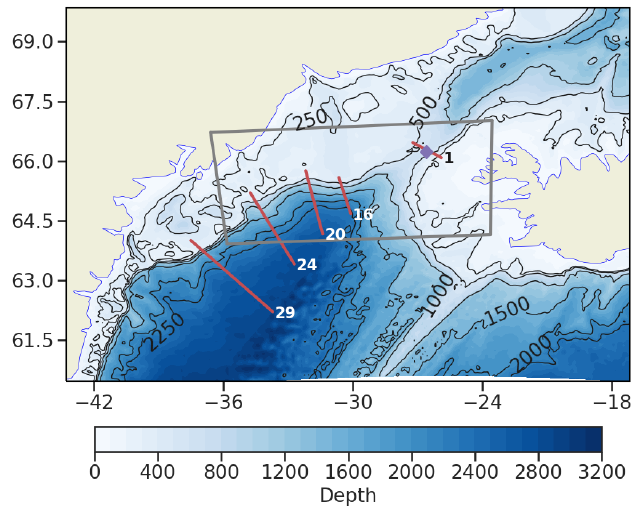
Figure 1. Regional model domain with the ocean depth in colour. The 250, 500, 1000, 1500, and 2000m depth isobaths are contoured in black. The grey box indicates the region where the two-way grid refinement (1 / 36 and 1 / 60 ◦ ) is applied in some simulations. The locations of the various sections used to monitor the model solution are shown by the red lines. Section 1 is the reference section chosen for the